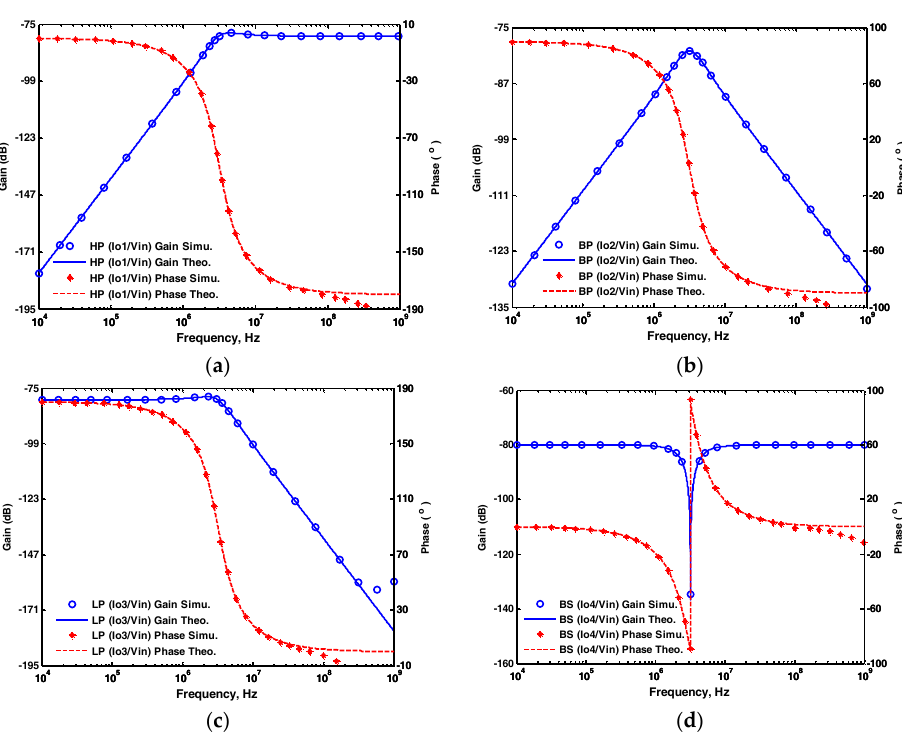
Figure 8. The TAM-simulated frequency responses of Figure 2 ( a ) highpass filter; ( b ) bandpass filter; ( c ) lowpass filter; and ( d ) bandstop filter. Appl. Sci. 2017 , 7 , 244